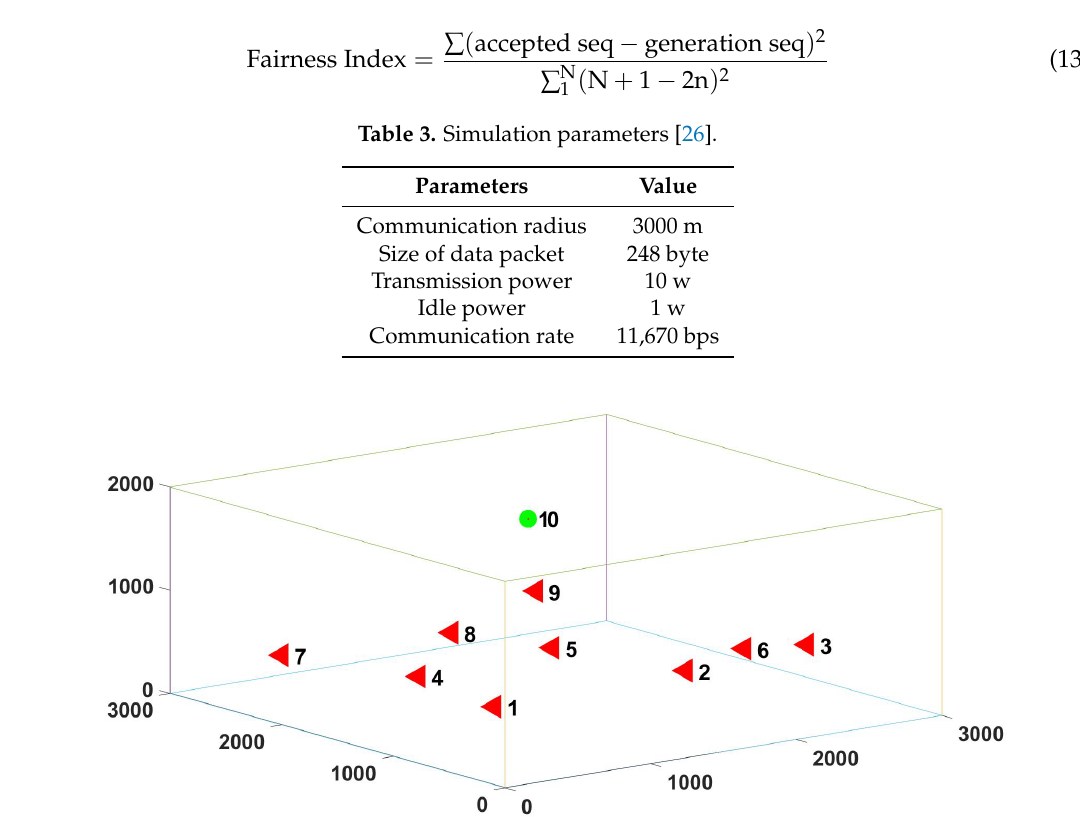
Figure 5. Topology of 10 nodes simulation network.